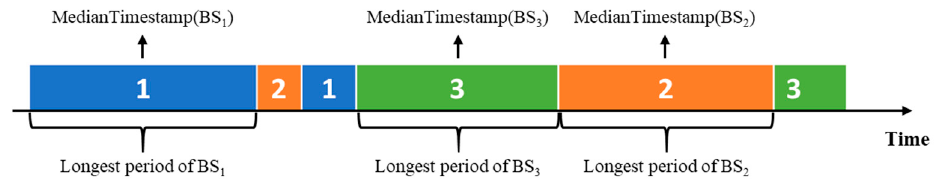
Figure 4. Timeline of the base stations handover in a cellular signaling sequence. The median timestamp of BS i (cid:48) longest period is represented by a function MedianTimestamp ( BS i ) . Here, N = 3 in this instance.